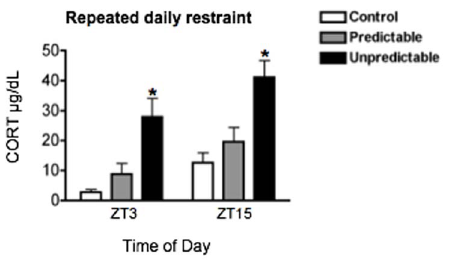
Figure 10. The effect of stress predictability on plasma corticosterone (CORT). Plasma CORT levels in response to 30 min restraint at ZT2 or ZT14 in rats previously exposed to repeated daily predictable vs. unpredictable restraint stress for 10 days during the day or night. Rats were killed 1 h after stress onset, at ZT 3 or ZT15. Means 6 SEM are shown, n =4 per group; * significant difference from corresponding control group, p , 0.05.